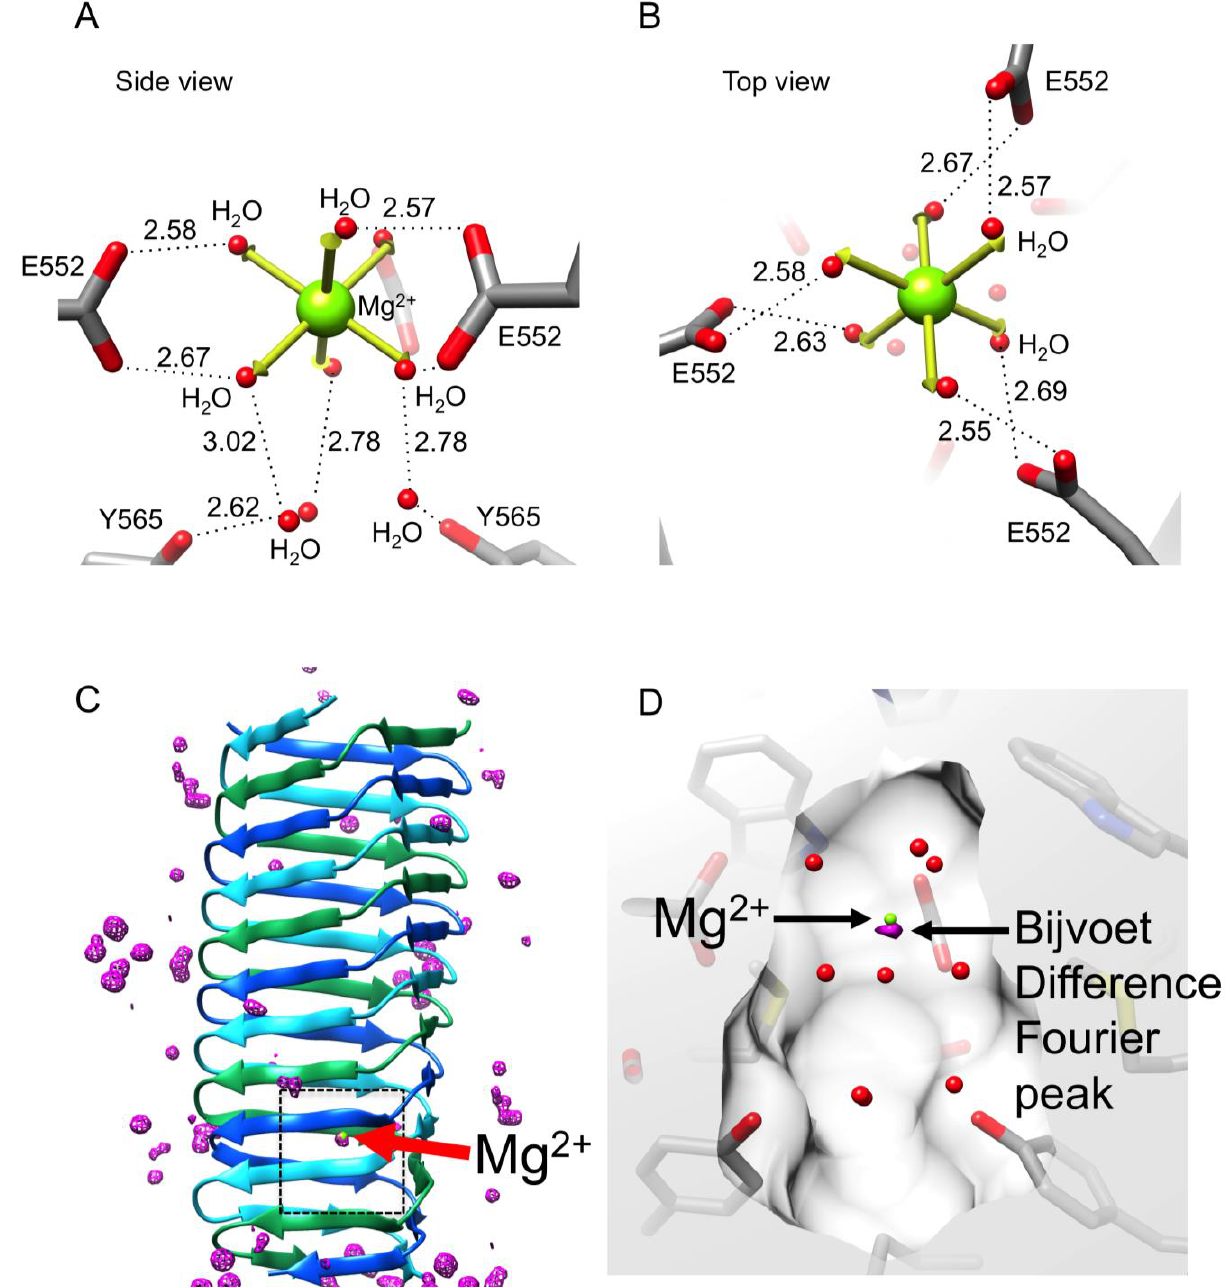
Figure 8. Identification and structure of the buried metal ion. ( A ) and ( B ) Side and top view of the metal ion geometry. The vertices of an ideal octahedron corresponding to waters being 2.16 Å away from the central atom are shown with thick yellow arrows; ( C ) The Bijvoet difference Fourier map (purple) is contoured at five standard deviations above the mean. The black dashed rectangle roughly corresponds to the area shown in ( D ); ( D ) The center of the Bijvoet difference Fourier peak (purple, contoured at 7.5 standard deviations above the mean) does not coincide with the refined position of the Mg 2+ ion.